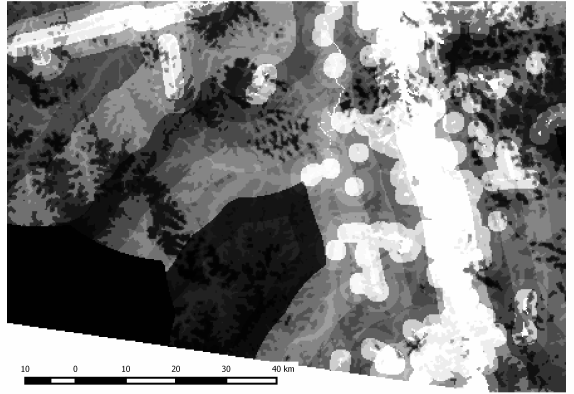
Figure 4: Map of probability of deforestation (1997)